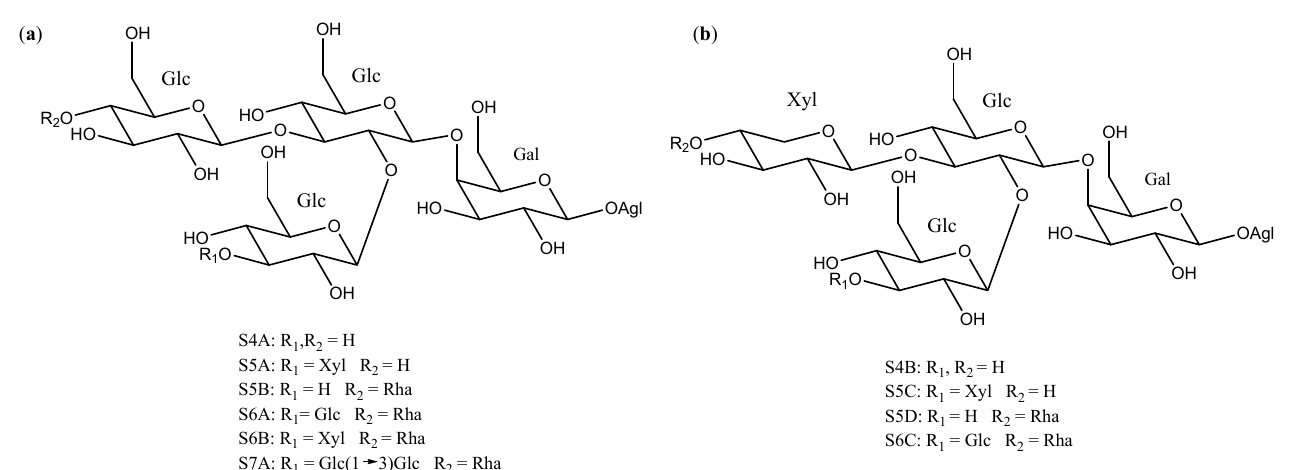
S5B: R 1 = H R 2 = Rha S6A: R 1 = Glc R 2 = Rha S6B: R 1 = Xyl R 2 = Rha S7A: R 1 = Glc(1 3)Glc R 2 = Rha Figure 7. Structure of Yucca polysaccharides S4A to S7A ( a ) with a β - D -galactopyranose and three β - D -glucopyranoses and ( b ) with a β - D -galactopyranose, two β - D -glucopyranoses and a β - D -xylopyranose core. Gal = galactose; Glc = glucose; Xyl = xylose and Rha = rhamnose.